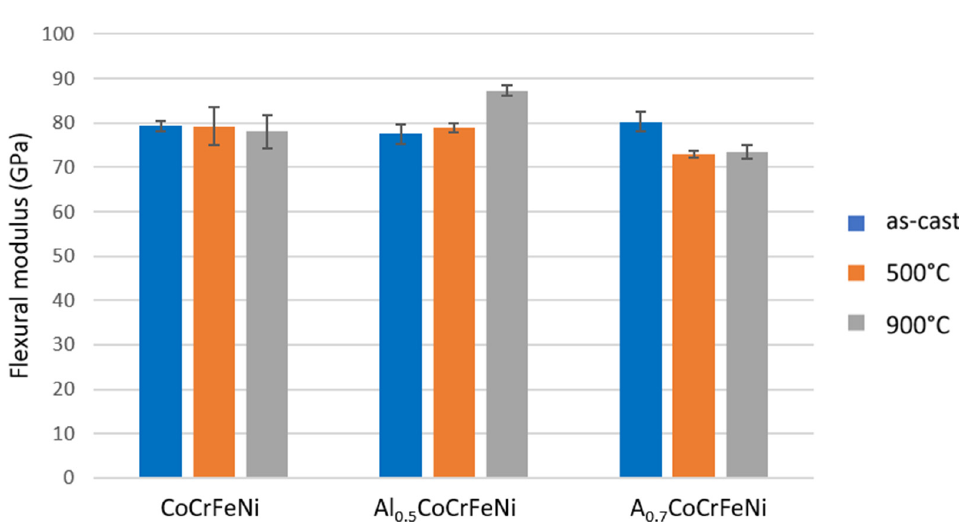
Figure 11. Determined flexural modulus.